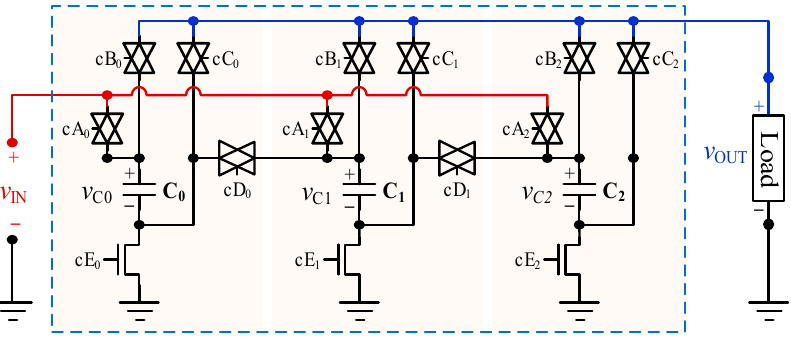
Figure 7. Capacitor bank circuit diagram with three switched capacitor branches.